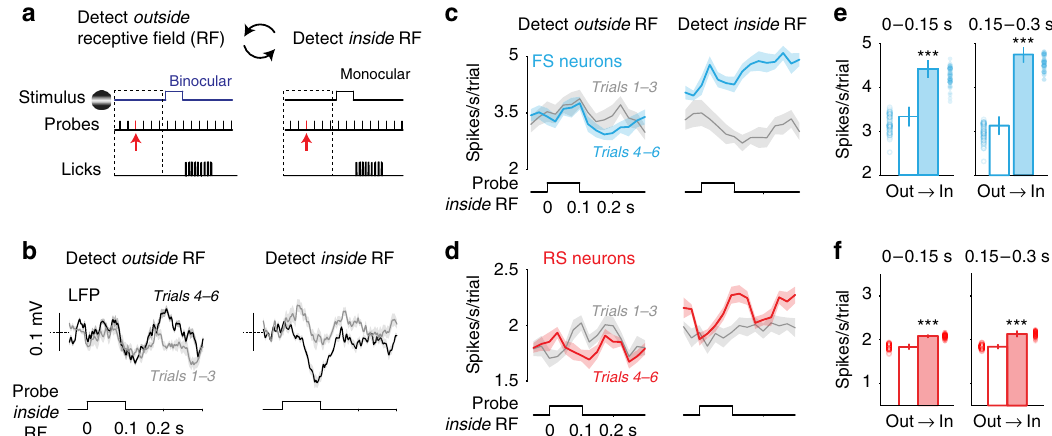
Fig. 3 Spatially selective enhancement of LFP, excitatory and inhibitory spiking. a Task-irrelevant probe stimuli ( fl ashed bars, 0.1 s duration) appear randomly across the entire visual fi eld during spatial detection trials. In monocular V1, binocular detection trials elicit attention outside the receptive fi eld (RF), while monocular detection trials elicit attention inside the RF. Responses to identical probes (red arrow) computed during the interval preceding correct detection, and compared across stimulus blocks. b Left, during detect outside RF trials, LFP responses to probes inside the RF are not different on Trials (1 – 3) (gray) versus Trials (4 – 6) (black). Right, during detect inside RF trials, LFP responses to same probes are signi fi cantly enhanced across consecutive trials (79 ± 38%; p < 0.05, Wilcoxon rank-sum test, throughout fi gure). Mean ± s.e.m. (15 mice, 21 recording sessions from monocular V1). c Same sessions as b , for spikes from fast spiking (FS) putative inhibitory neurons ( n = 67, all layers). Detection inside the RF increased FS probe responses by 1.1 ± 0.4 spikes per s per trial ( p < 0.001, rank-sum test ) . Mean ± s.e.m. d Same as c , for spikes from regular spiking (RS) putative excitatory neurons ( n = 225, all layers). Detection inside the RF increased RS probe responses by 0.2 ± 0.1 spikes per s per trial ( p < 0.001, rank-sum test ) . Mean± s.e.m. e FS neurons show enhanced probe responses for both early (<0.15 s; out: 3.3 ± 0.2 vs in: 4.4 ± 0.2 spikes per second, p < 0.001 rank-sum test) and late sensory activity (0.15 – 0.3 s; out: 3.1 ± 0.2 vs in: 4.8 ± 0.2 spikes per second, p < 0.001, rank-sum test) following stimulus onset. Late activity signi fi cantly greater than early on detect inside RF trials ( p < 0.05, rank-sum test). f Same as e , for RS neurons early (out: 1.8 ± 0.06 vs in: 2.08 ± 0.05 spikes per second, p < 0.001, rank- sum test), late (out: 1.8 ± 0.04 vs in: 2.13 ± 0.07 spikes per second, p < 0.001, rank-sum test). Late activity signi fi cantly greater than early on detect inside RF trials ( p < 0.05, rank-sum test). *** p <